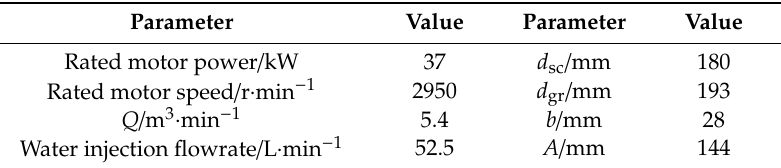
Figure 4. The fabricated SSC: ( a ) casing and gate-rotor; ( b ) screw rotor.